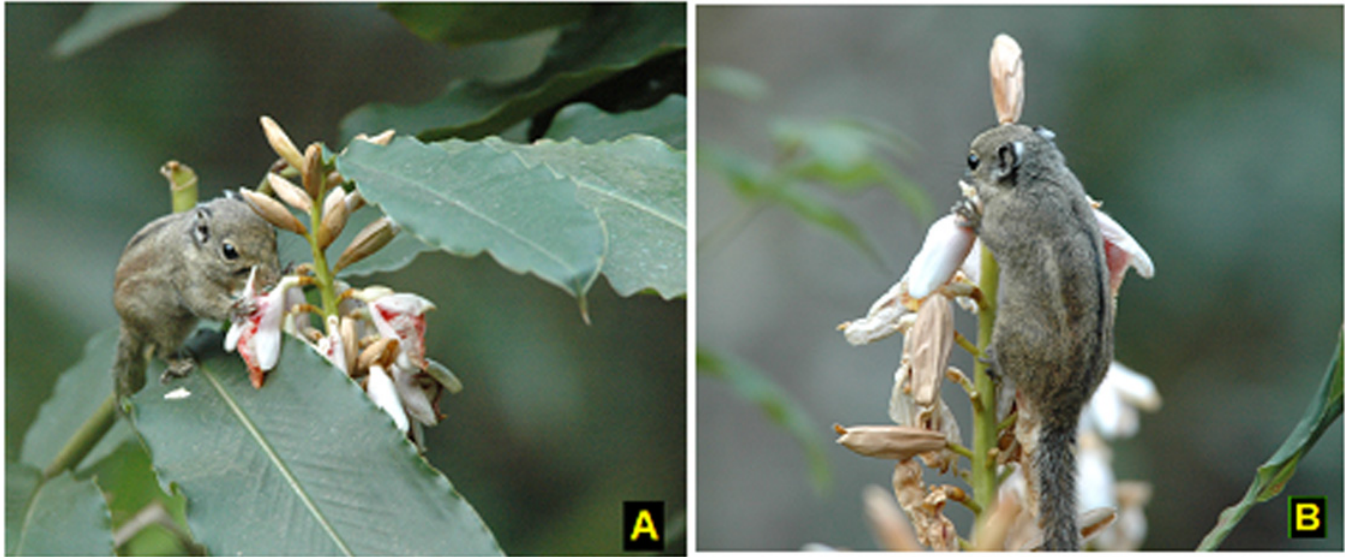
Fig 1. (A) A major nectar-robber, striped-squirrel ( Tamiops swinhoei ) robbing the nectar of A . roxburghii flowers, showing damage to the flower and the broken style. (B) Striped-squirrel makes a hole at the base of the flower corolla and sucks the nectar, through this behaviour squirrel damages the